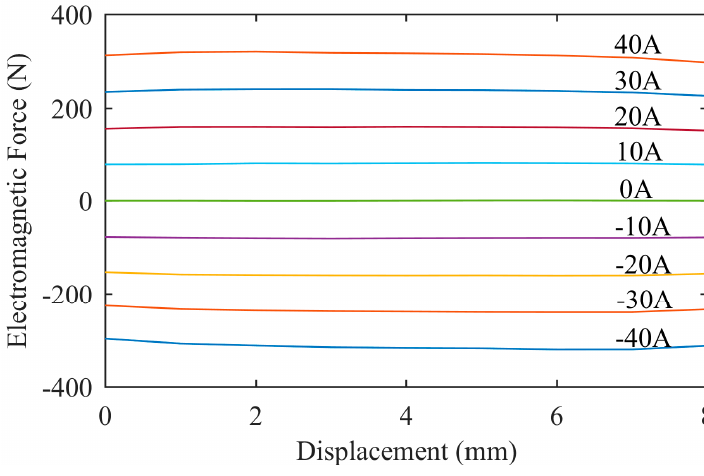
Figure 3. Electromagnetic force characteristic curve.